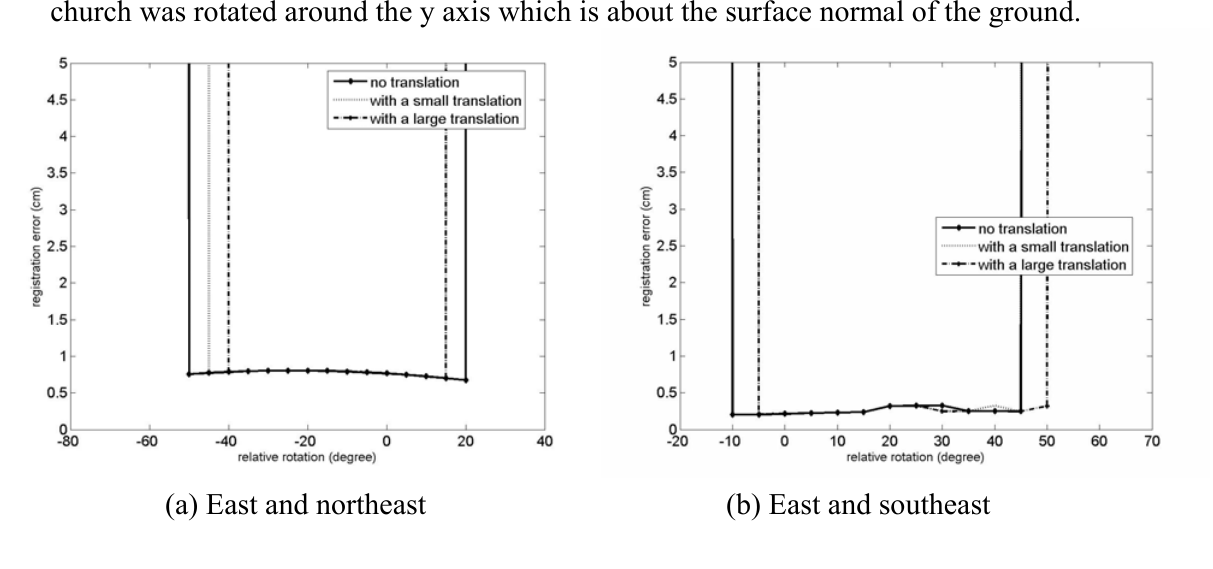
0  iter T , for the convergence region test of the cedis tan